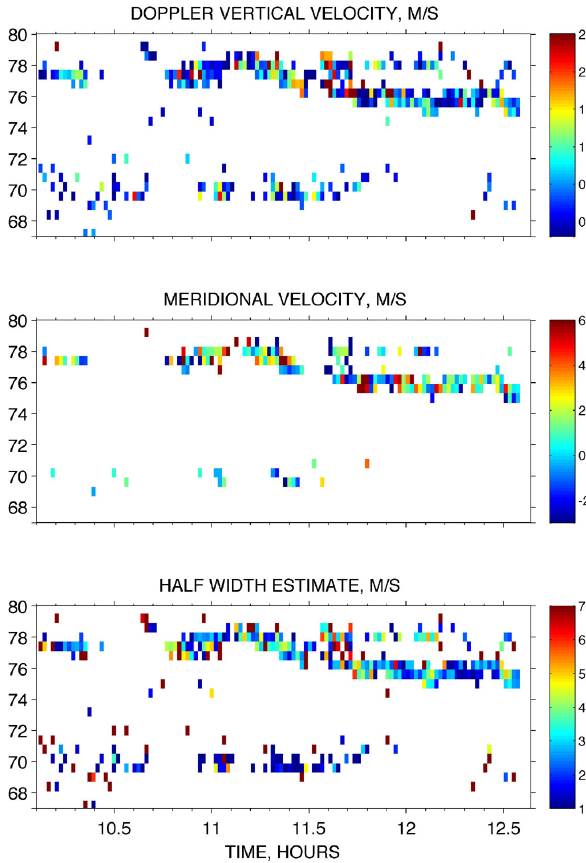
Fig. 5. Log 10 of radar volume reflectivity for the vertical (upper panel) and tilted (middle panel) beam and their ratio (lower panel) for the experiment on 11 April 2009. The vertical axis is altitude in km.